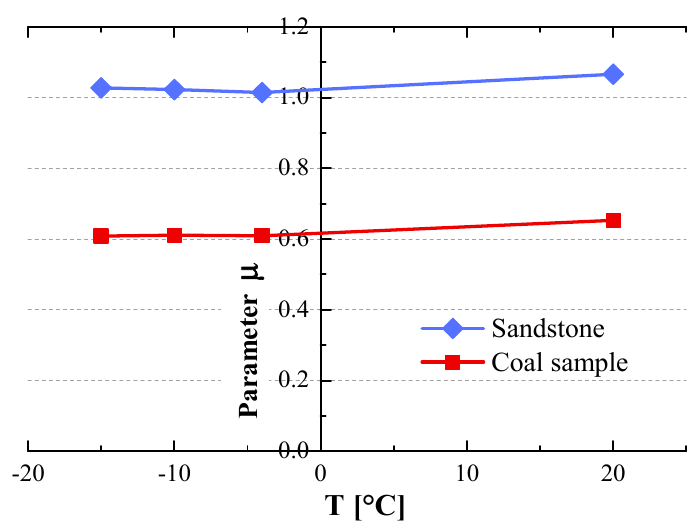
Figure 6. Relationship of parameter µ ( T ) and temperature.